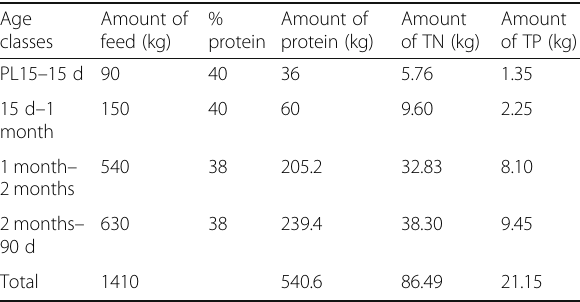
Table 3 Amount of TN and TP in the